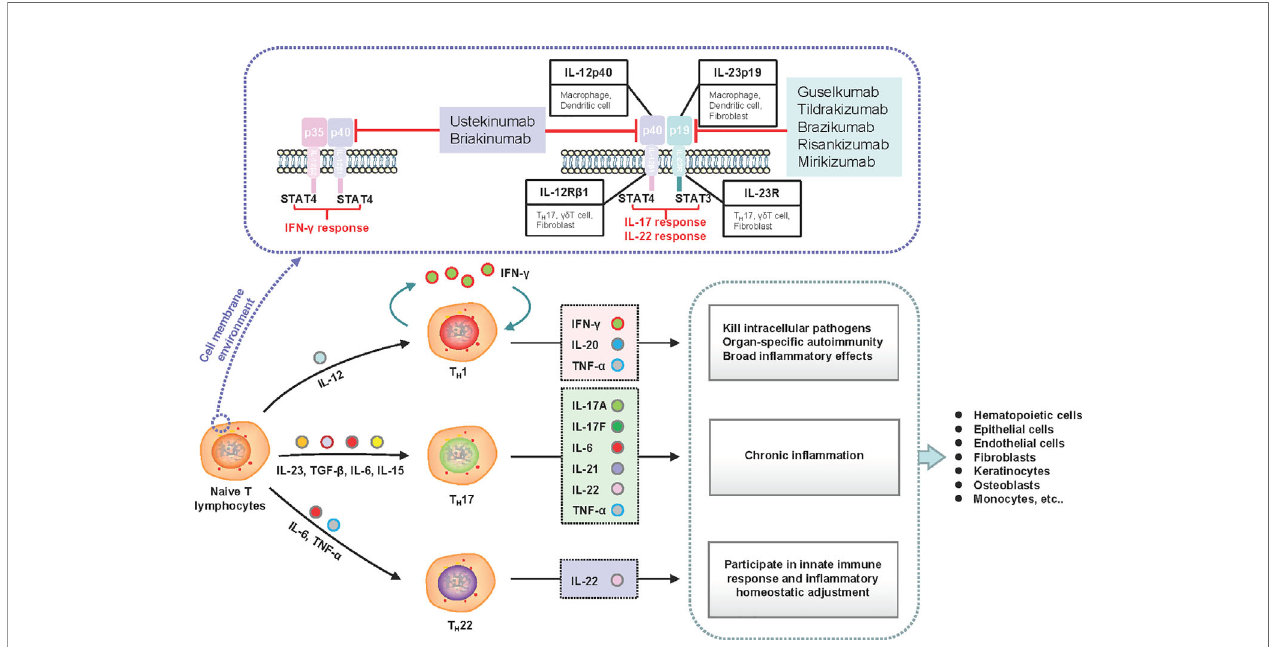
FIGURE 2 | Schematic of the induction and effects of IL-23 subunits and their corresponding receptors and signaling molecules. IL-23 is an essential factor required for the expansion of naive CD4 + T lymphocyte populations. The functional IL-23 receptors include IL-12R b 1 and IL-23R. The downstream signaling molecule of IL-23R is STAT3, which drives T H 17 and T H 22 responses. The downstream signaling molecule of IL-12R b 1 is STAT4, which drives the T H 1 response. Under stimulation with different cell factor combinations, naive CD4 + cells differentiate into T helper (T H 1, T H 17, and T H 22) cells to produce corresponding in fl ammatory factors and execute their functional activities. Inhibiting the upstream subunits (IL-12R b 1 or IL-23R) can govern both upstream and downstream processes in the cascade to improve clinical symptoms. IFN, interferon; IL, interleukin; STAT, signal transducer and activator of transcription; T H , T helper; TGF, transforming growth factor; TNF, tumor necrosis